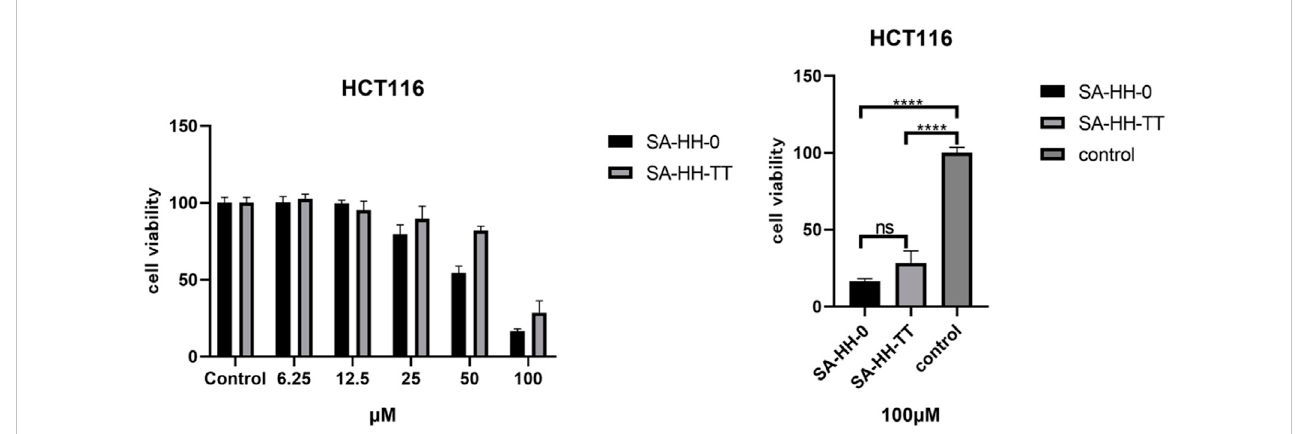
FIGURE 9 Effects of Samoamide A derivatives on cell viability.